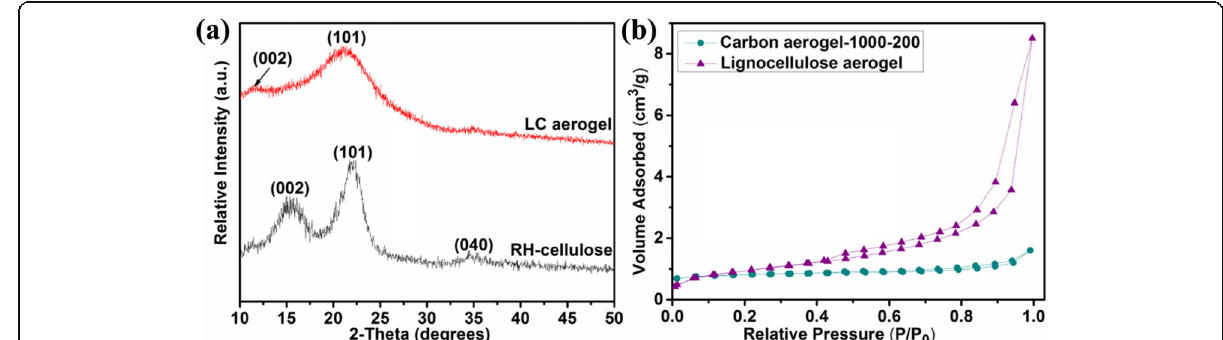
Fig. 3 a XRD patterns of the LC aerogel and the cellulose derived from RHs; b N 2 adsorption-desorption isotherms of the LC aerogel and carbon aerogel